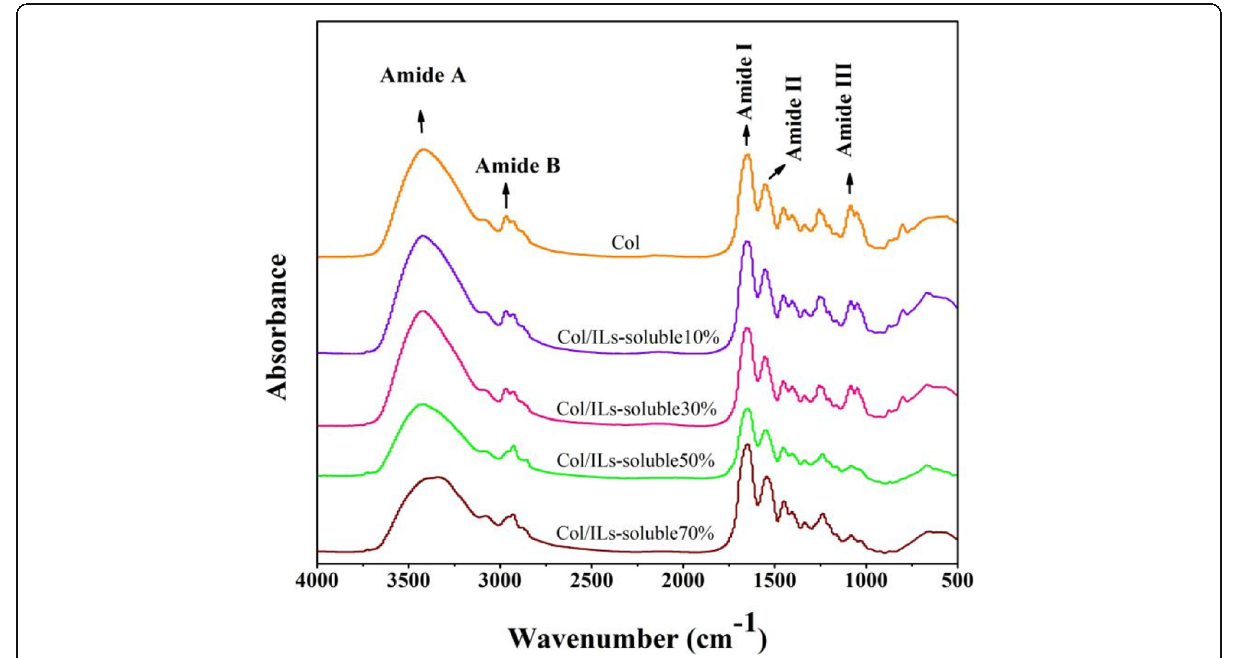
Fig. 5 FT-IR spectra of Col and collagen samples dissolved in different concentrations of